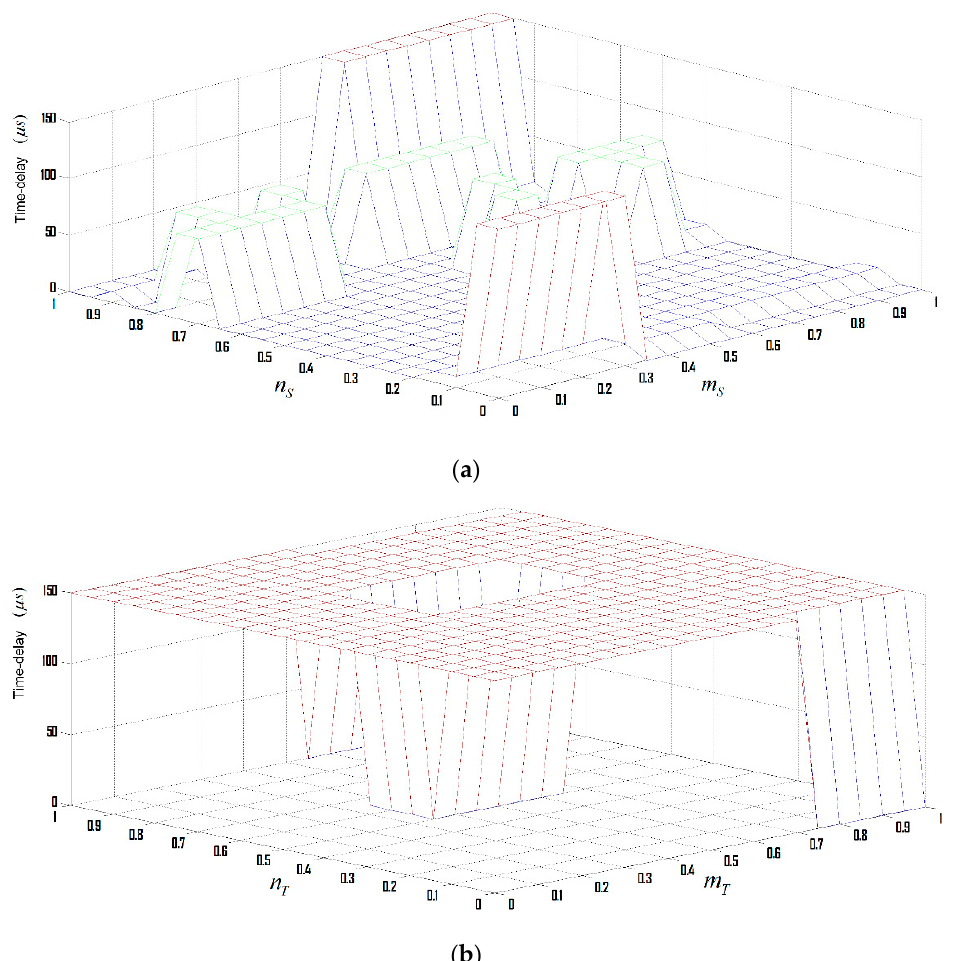
Figure 5. Upper limit value of time-delay whilst keeping system stable for different m S , n S , m T , and n T . ( a ) SPM. ( b ) TPM.